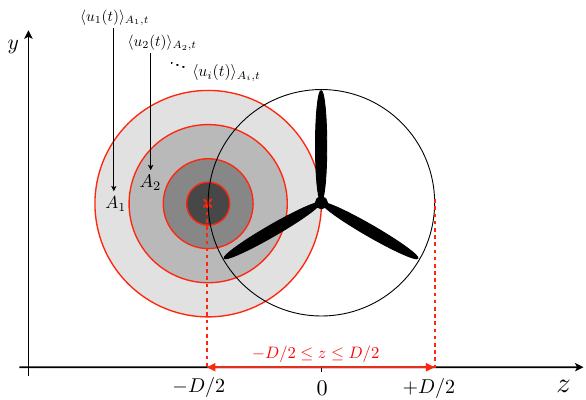
Figure 4. Illustration of the wake center detection method. The hub of a potential downstream turbine is located at the red × . (cid:104) u i ( t ) (cid:105) A is the spatially and temporarily averaged u component of the veloc- ity. The potential power P ∗ is calculated for each ring segment and then added up. This procedure is repeated for 50 horizontal hub lo- cations × , while the position resulting in the lowest value of P ∗ is interpreted as the wake